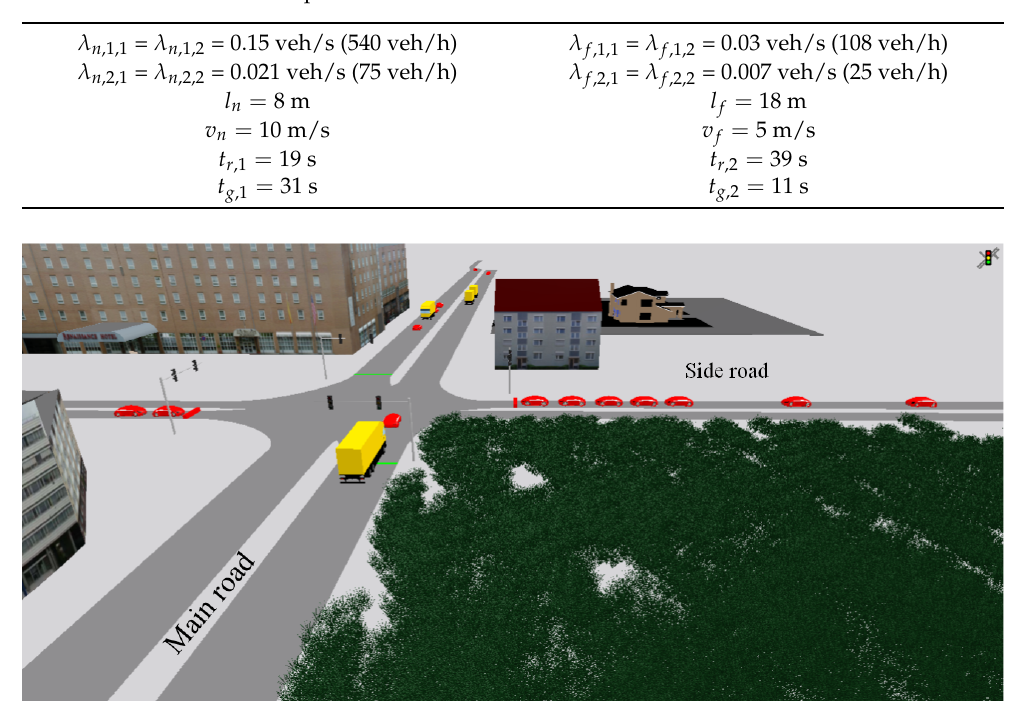
Table 1. Reference values of parameters.